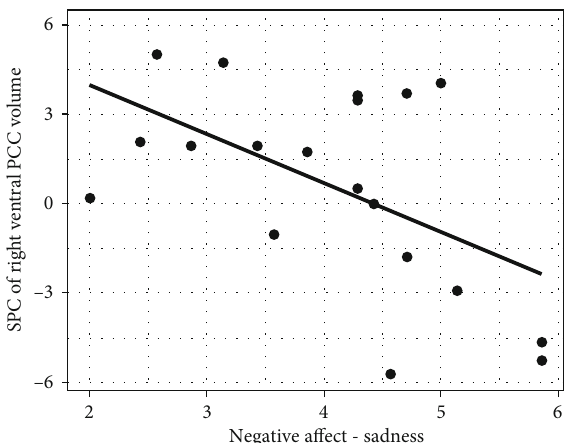
Figure 3: Relationship of negative a ff ect and SPC of right ventral PCC/ISC. Sadness negatively correlated with the spc of right ventral PCC/ISC.